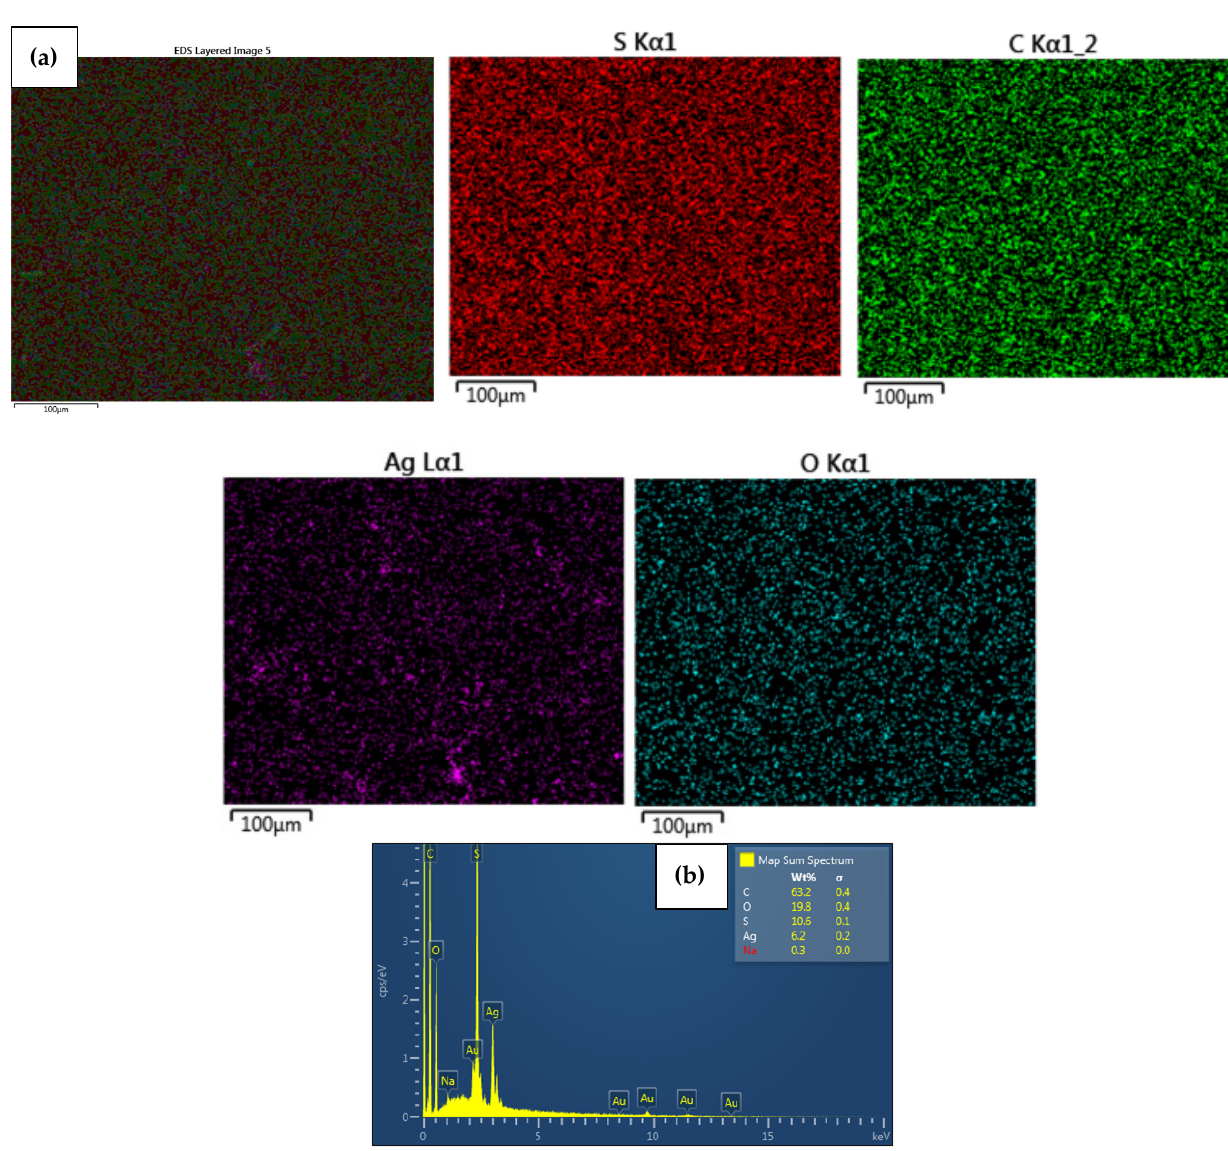
Figure 3. Elemental maps showing the composition of the analyzed CEM membrane surface; ( a ) combined elemental mapping of C, S, Ag and O and ( b ) EDS spectra confirming the presence of AgNPs of CEM-Ag3 nanocomposite membrane. Table 4. Ag and Cu average hydrodynamic particle diameters of Ag- and Cu-functionalized UF heterogeneous